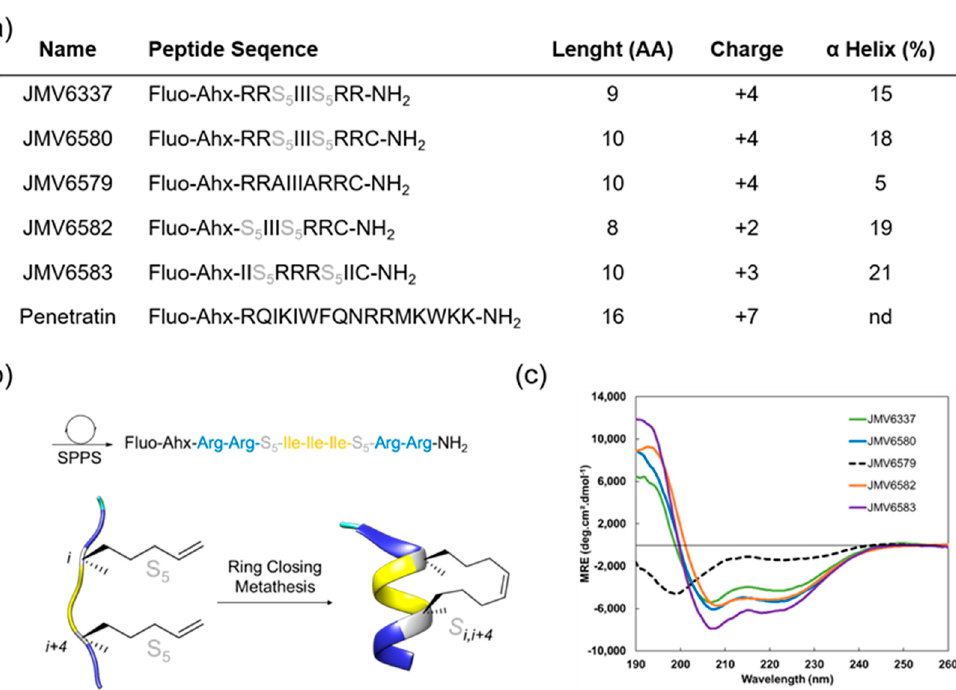
Figure 1. ( a ) Summary of fluorescent peptides used in this study. ( b ) Schematic representation of fluorescent stapled peptide synthesis by ring-closing metathesis (JMV6337), S5 corresponds to the (S)-pentenylalanine residue, ( c ) Overlay of far-UV circular dichroism (CD) spectra of stapled peptides. Experiment were performed at 20 °C in a water/TFE mixture (95/5).